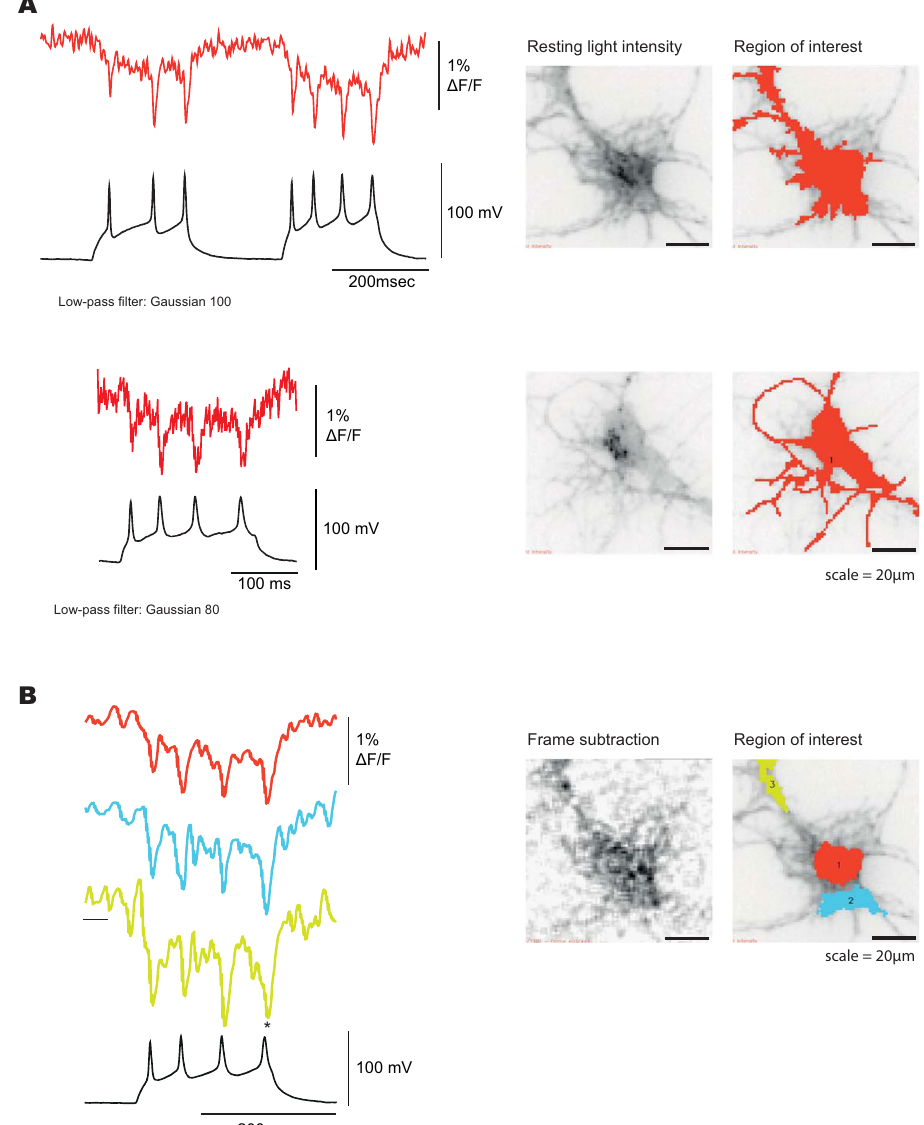
Figure 5. Optical signal from Ilmol in response to action potentials. ( A ) Hippocampal neurons expressing Ilmol were imaged under current clamp. Top trace is a higher quality signal from a single trial recording at 1000 hertz yielding a 1.5% signal/action potential. Bottom trace is a lower quality signal giving a 1% signal per action potential. Corresponding neurons are shown on the right. Resting fluorescence is the grey scale image. Regions of interest generating traces on the left are shown in red. ( B ) Optical traces of Ilmol from different regions of a neuron (soma: red, processes: blue and yellow). The corresponding region of interest is shown on the right. Image on the left shows the changes in fluorescence during action potential. A frame subtraction image was generated by subtracting the average fluorescence of the three frames during the action potential (denoted by an asterisk) from the average fluorescence of 20 frames before the onset of action potentials (denoted by black bar below the yellow